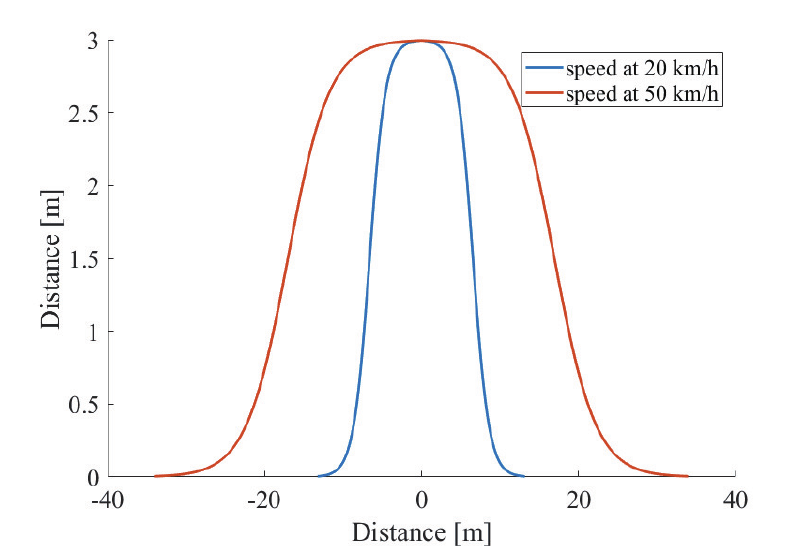
Figure 5. The examples of two driving paths where the duration to complete the overtaking is 5